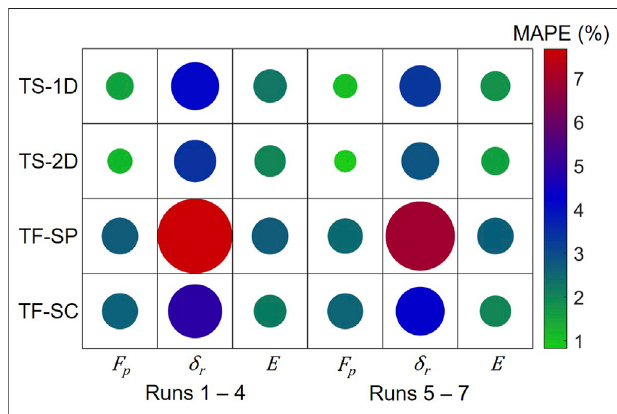
FIGURE 8 | Comparison of each trained network in capturing the engineering metrics when prompted with the evaluation dataset. The size and color of the circles are proportional to the error